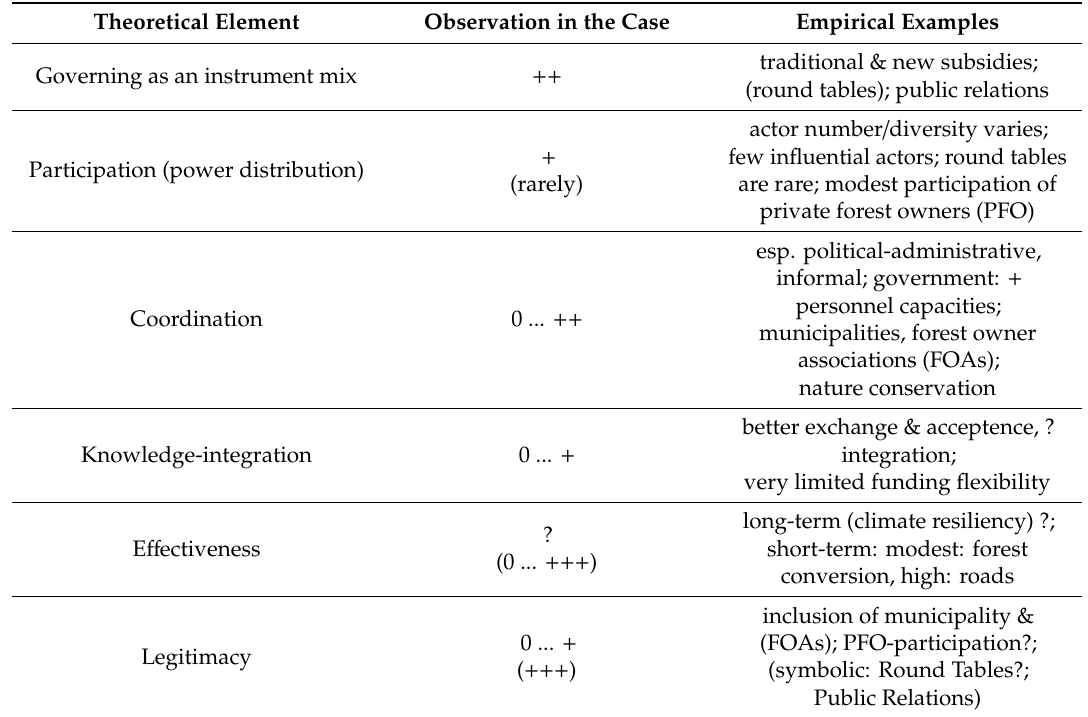
Table 2. Comparison of theoretical new environmental policy instrument (NEPI) advantages with empiric